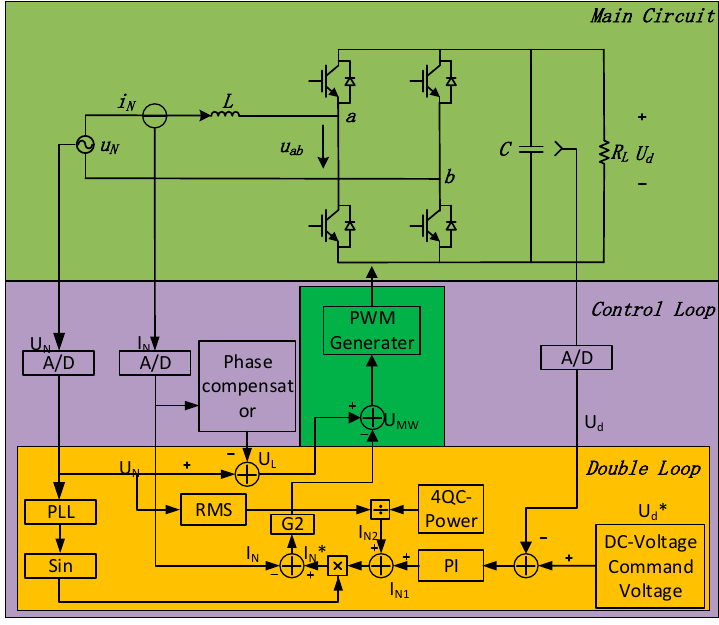
Figure 2. Diagram of four-quadrant converter (4QC).